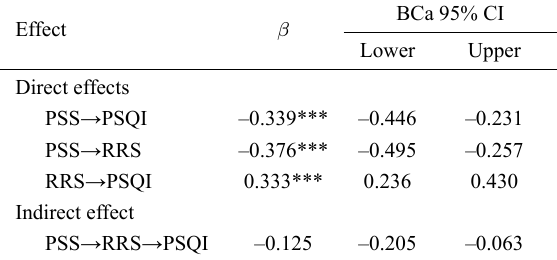
Table 4. Testing the pathways of the mediation